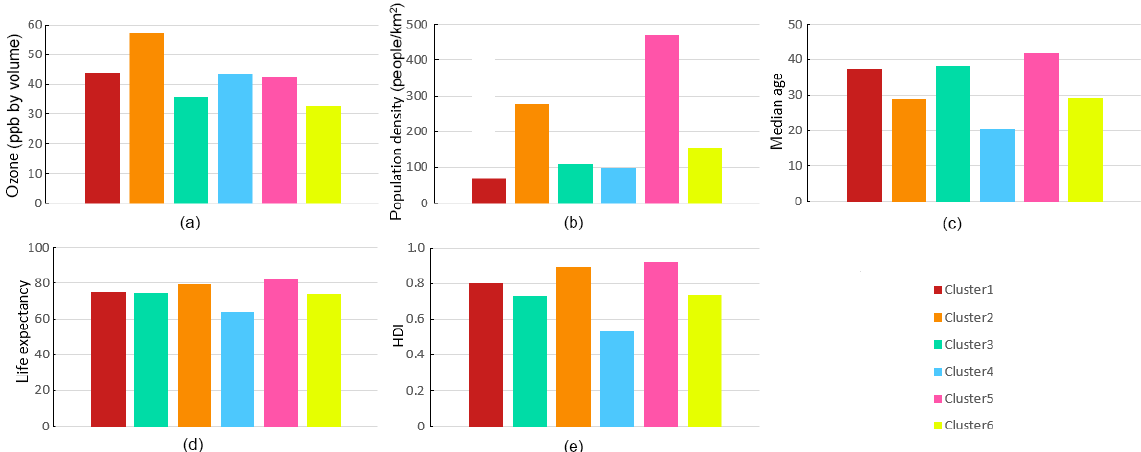
Fig. 12 Bar charts of mean values of influencing factors on the spread or diffusion of COVID-19 for each